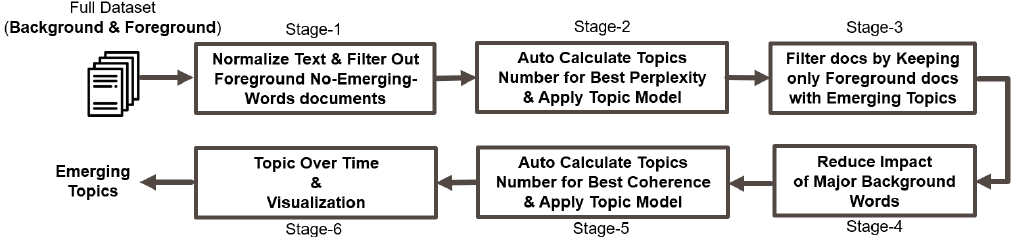
Figure 7. Filtered-LDA Model.